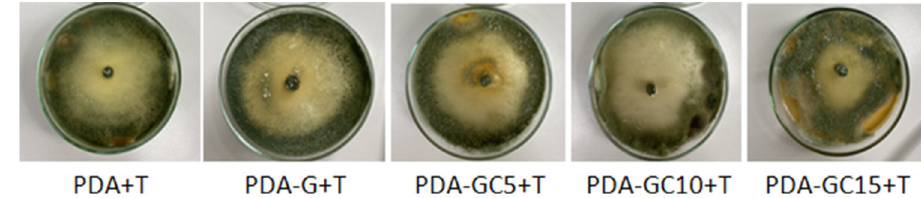
Figure 11. Growth of T. harzianum KUEN 1585 on PDA medium poisoned with G and GC mixtures on 7th day.